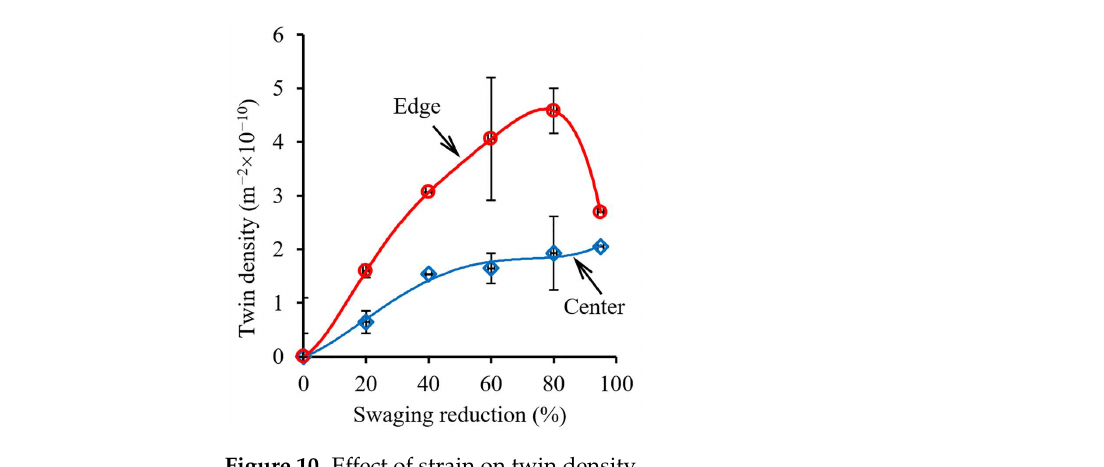
Figure 10. Effect of strain on twin